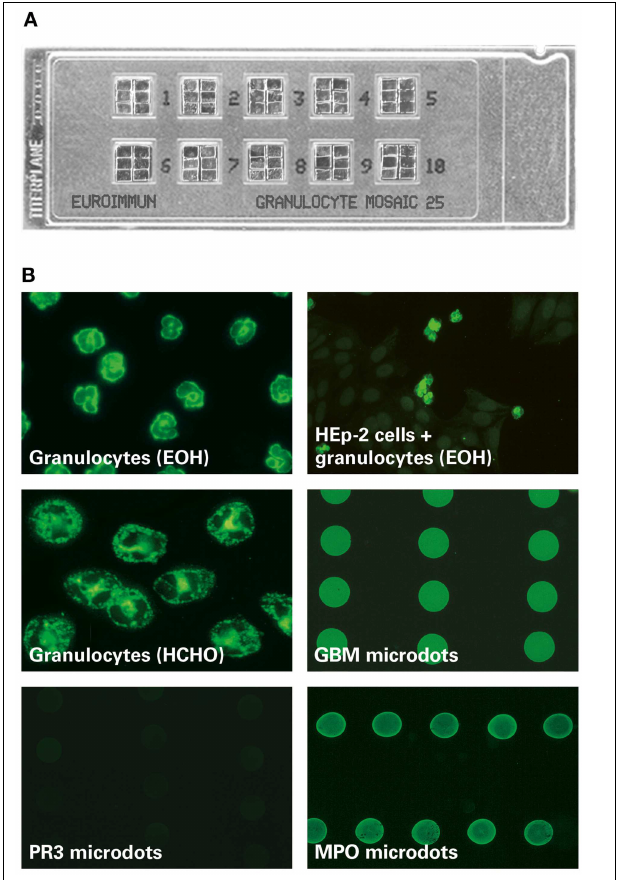
FIGURE 1 | MPO-ANCA fluorescence pattern on the EUROIMMUN EUROPLUS TM Granulocyte Mosaic (IgG) . (A) Examplary microscope (B) Inthe with 10 reactionfields,eachcontaining6biochipsformingamosaic. EUROPLUS TM GranulocyteMosaic,eachbiochiprepresentsadifferentsubstrate: ethanol-fixedgranulocytes[granulocytes(EOH)],formalin-fixedgranulocytes [granulocytes(HCHO)],HEp-2cellsincombinationwithethanol-fixedgranulocytes [HEp-2cells + granulocytes(EOH)]aswellasPR3,MPO,andGBMmicrodots.The exemplaryimagesillustratethereactivityofapatientsamplepositiveforanti-MPO andanti-GBM:BesidesaP-ANCApatternonethanol-fixedgranulocytesanda granularC-ANCApatternonformalin-fixedgranulocytes,MPO-ANCAis characterizedbyapositivefluorescencesignalonMPObutnotonPR3microdots. InadditionapositivefluorescencesignalonGBMmicrodotsisshown.